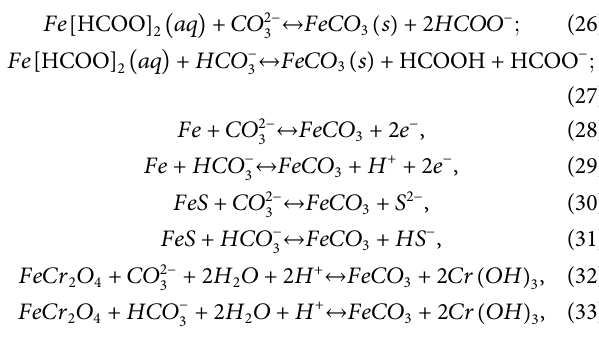
Frontiers in Materials |